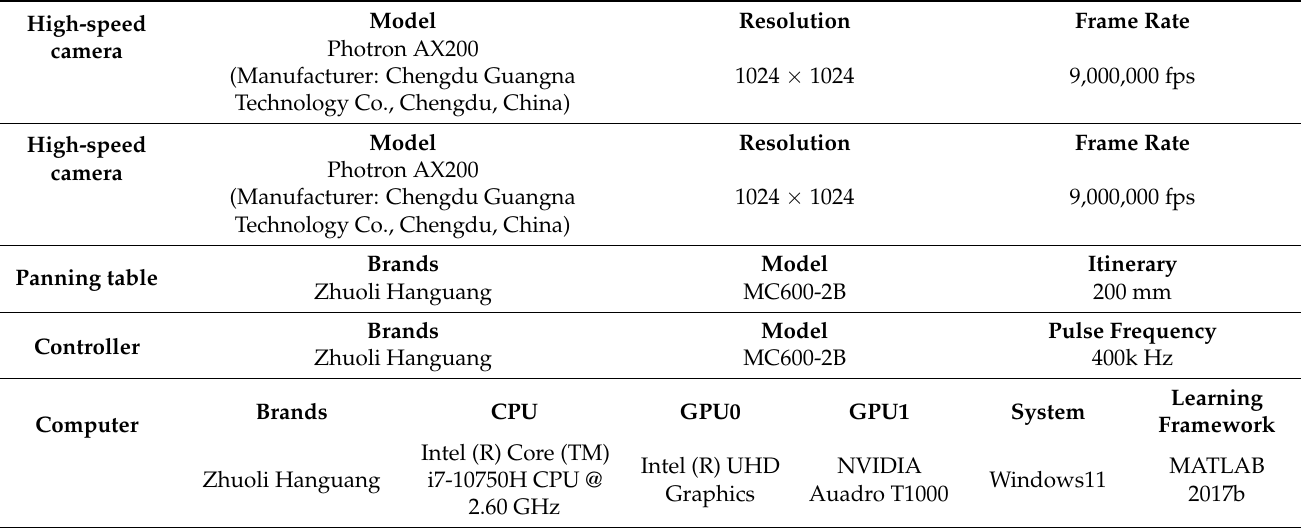
Figure 4. Laboratory environment map. ( a ) The high-speed camera. ( b ) Experimental system diagram. Table 2. Hardware configuration of experimental